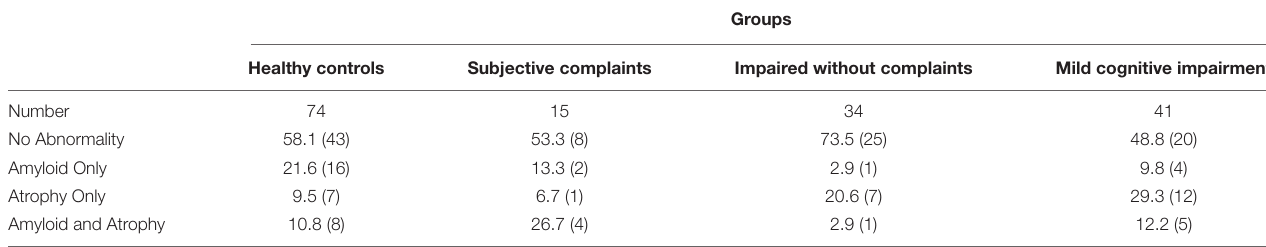
TABLE 5 | Summary amyloid and atrophy findings among four subject [Percent(N) Within